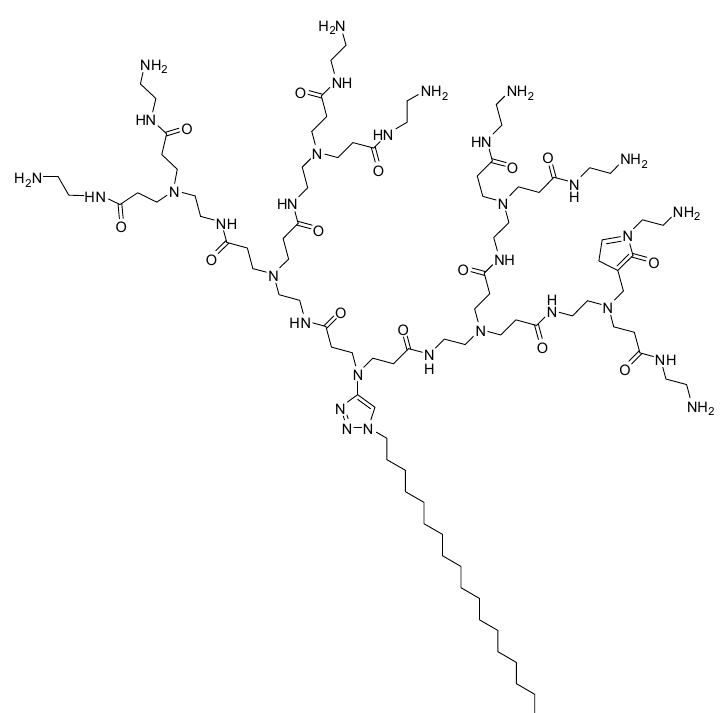
Figure 11. Amphiphilic promising dendron for small interfering RNA (siRNA) delivery [94].